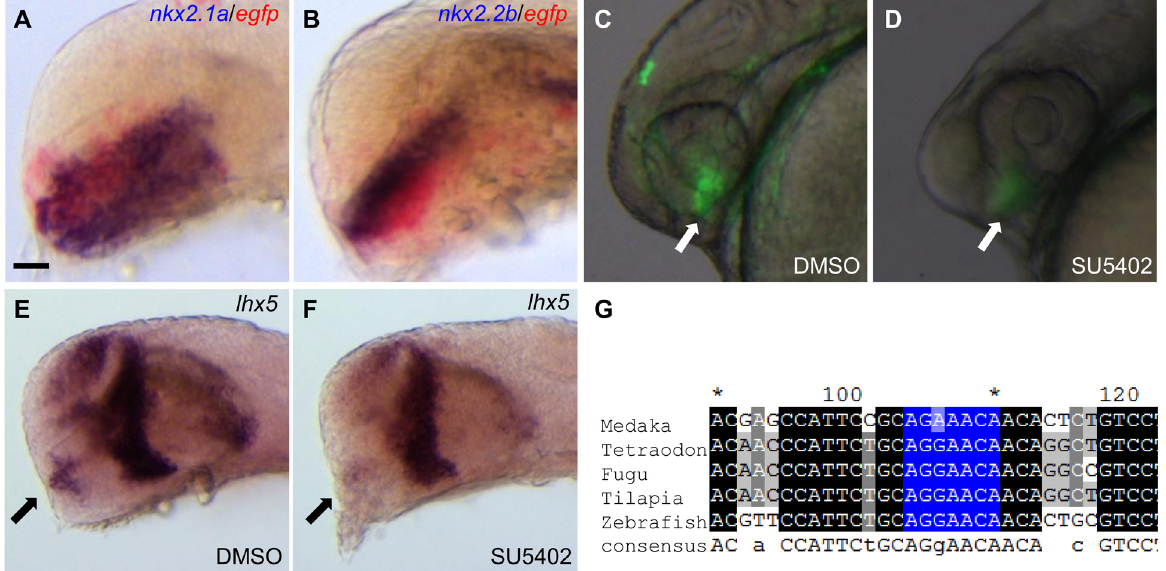
Fig 3. CNS2 contains hypothalamic enhancer activity and responses to FGF signaling. ( A-B ) Double in situ hybridization results indicate CNS2 contains hypothalamic enhancer activity. The hypothalamic marker nkx2 . 1a and nkx2 . 2b are stained in dark blue, reporter egfp stained in red. ( C-D ) SU5402 treatment severely reduces CNS2 activity. Vehicle DMSO treated embryos show restricted hypothalamic EGFP reporter expression (pointed by the arrow in C). Embryos treated with the FGF signaling inhibitor SU5402 during the segmentation stage (10-24hpf) show minimal EGFP signals in the hypothalamic region (arrow in D, n = 48/55). ( E-F ) SU5402 treatment down-regulates endogenous lhx5 expression in the hypothalamic region. Endogenous lhx5 shows robust expression in the hypothalamic region (pointed by the arrow in E). SU5402 treatment during the segmentation stage down-regulates lhx5 expression in the hypothalamic region (arrow in F, n = 25/28). ( G ) Multiple sequence alignments of the CNS2 region in the five teleost species. The identified FGF downstream factor Pea3 binding site is highlighted in blue. Lateral view of the forebrain regions of embryos at 24 hpf (A-F), anterior to the left. Scale bar: 40 μ m in A-B; 50 μ m in